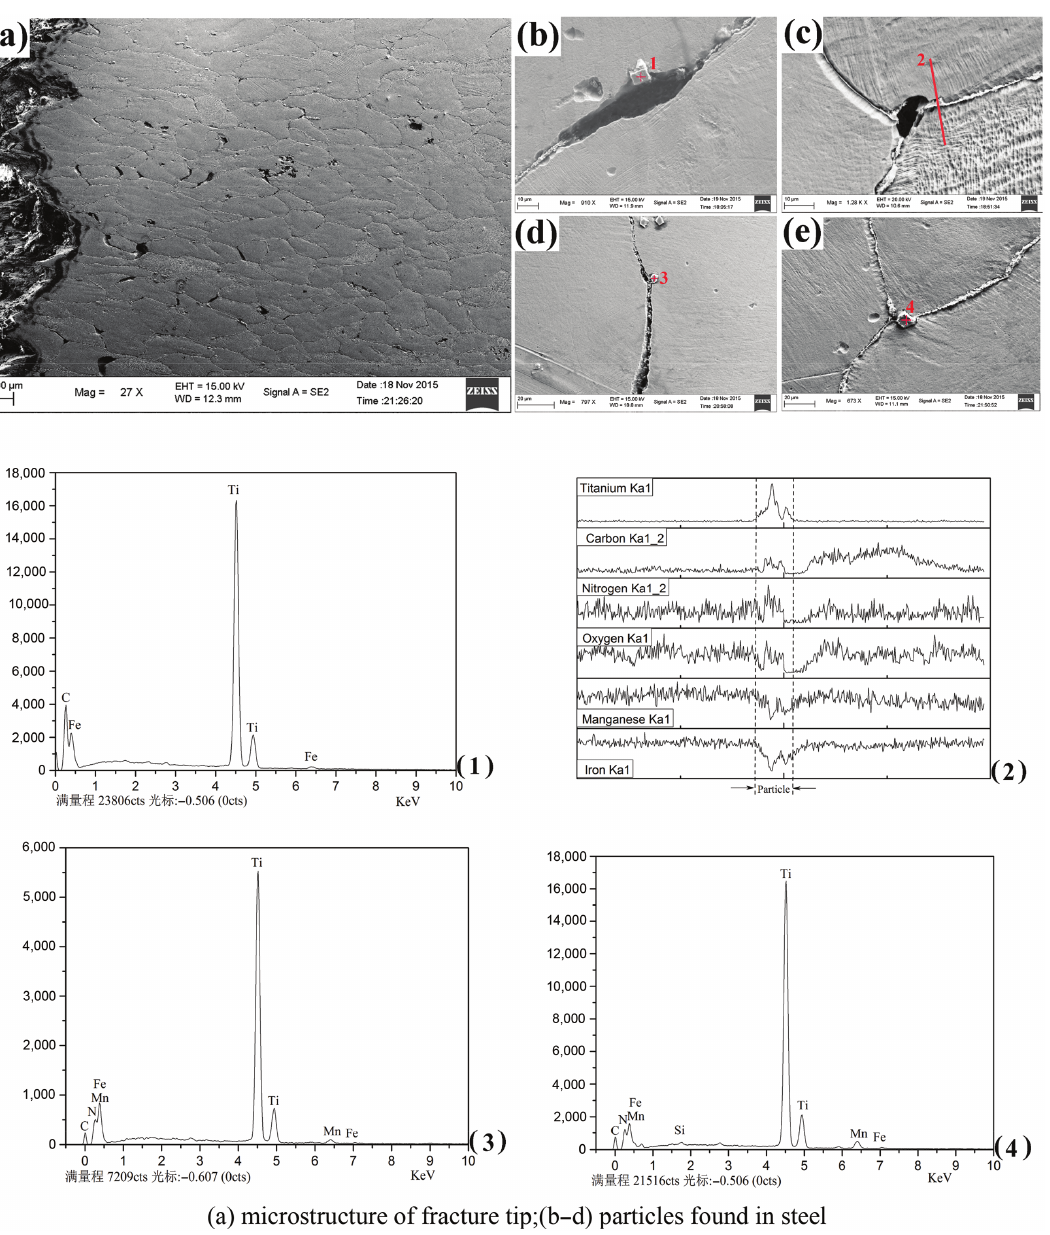
Figure 7: Microstructures and Ti(C,N) particles present in steel 2: tensile specimens were given test cycle shown in Figure 1 and tested at